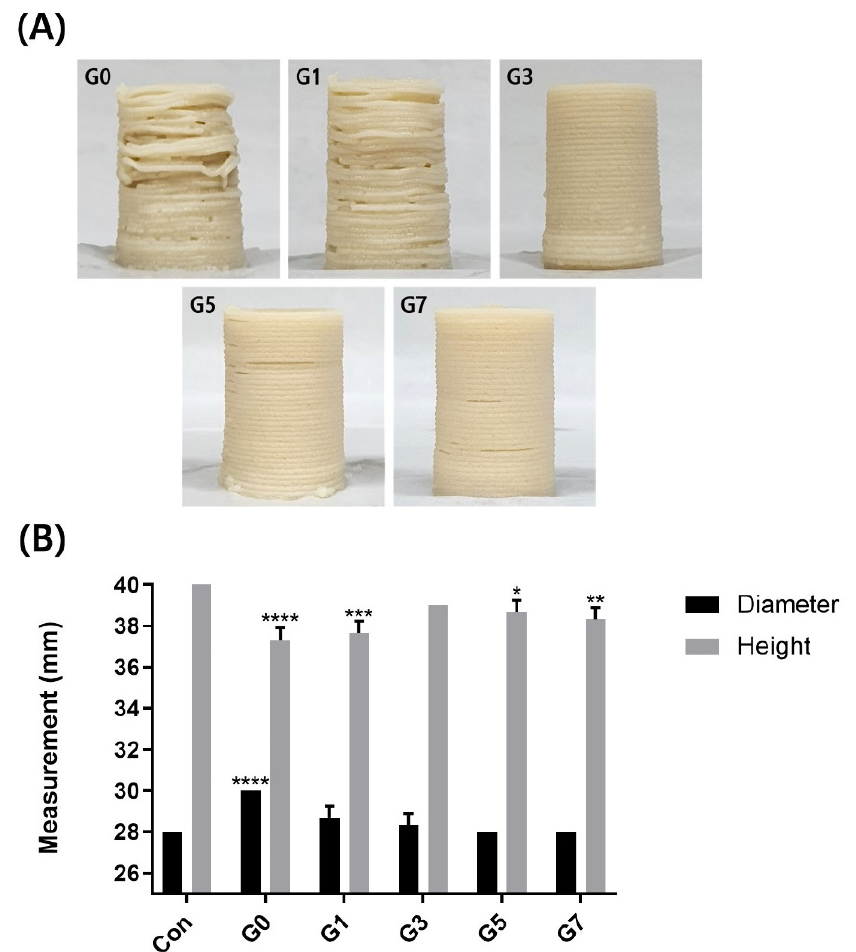
Figure 4. Cylindrical printing tests of Abalone 3D print ink with different concentrations of gelatin (G0, 0%; G1, 1%; G3, 3%; G5, 5%; G7, 7%) ( A ). Measurement of the diameter and height of cylindrical printing ( B ). Con indicated the original 3D model value (diameter of 28 mm, height of 40 mm). Error bars represent standard. * , ** , *** , **** p < 0.05 vs. diameter and height of Con by two-way ANOVA.